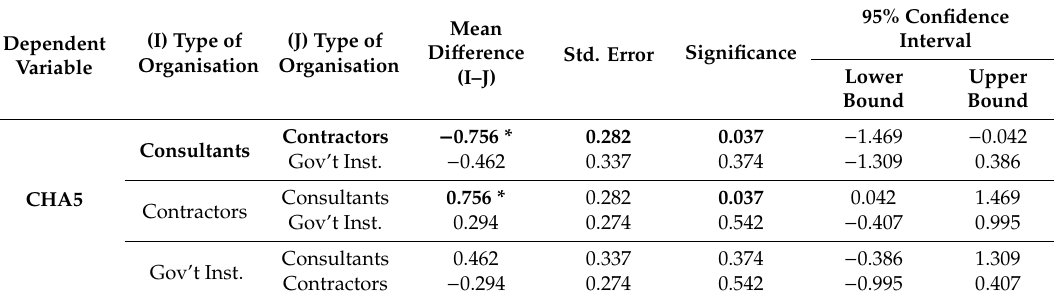
Table 6. Games–Howell HSD multiple